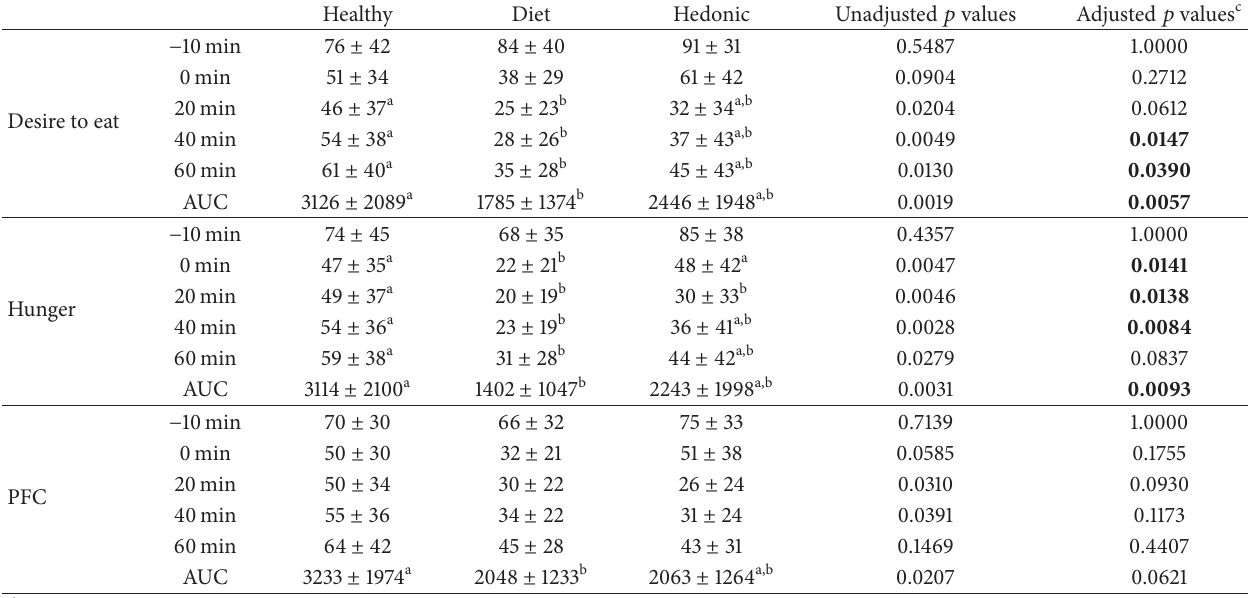
Table 5: Desire to eat, hunger, and PFC in normal-weight unrestrained women for each experimental condition. Healthy Diet Hedonic Unadjusted 𝑝 values